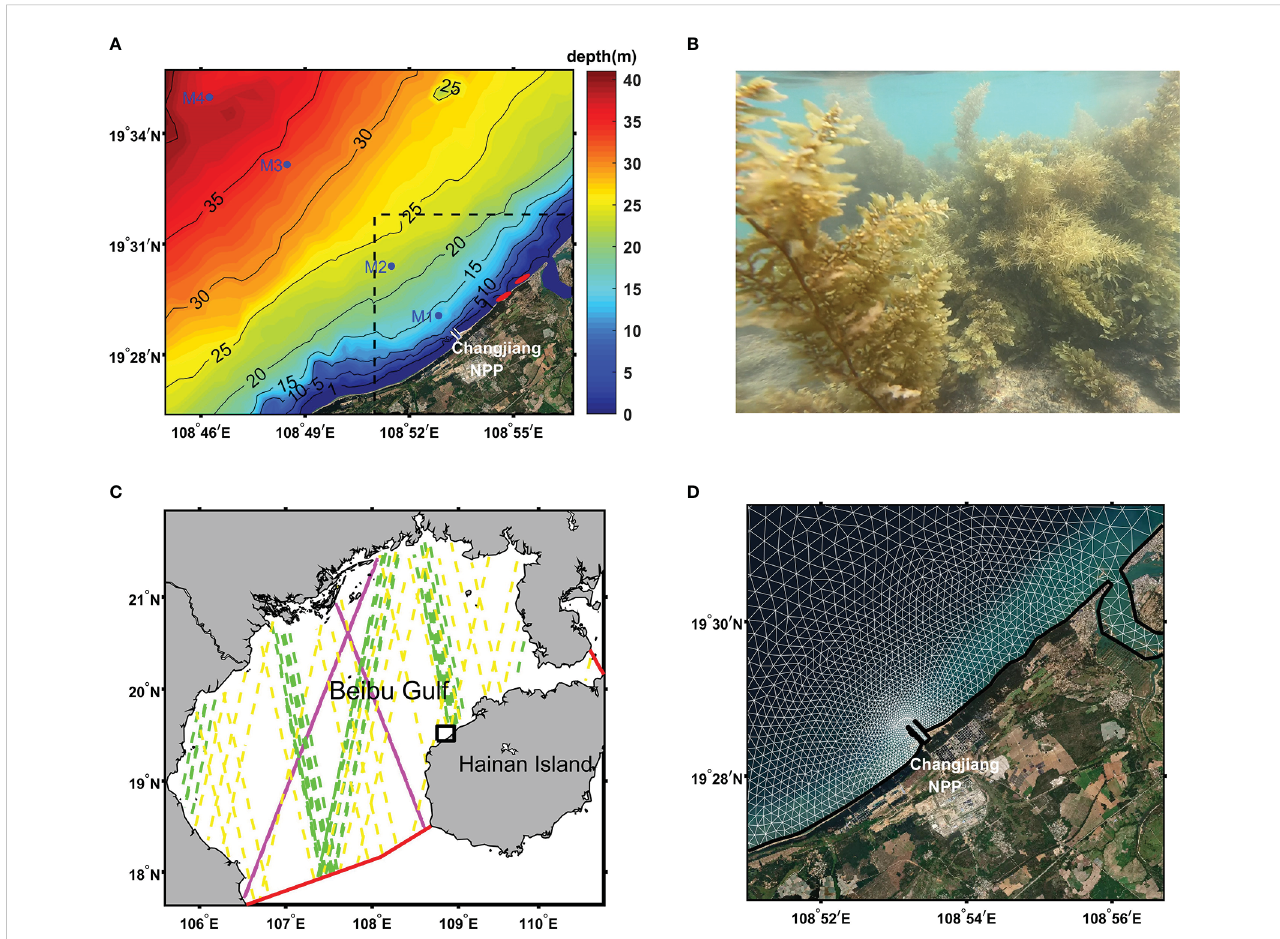
FIGURE 1 (A) The study region with bottom topography (colored shading). The positions of current stations are indicated by blue markers. The two red elliptical markers indicate the locations of two gulfweed source sites near the coast. The dashed rectangular box marks the area of particle release in particle- tracking simulations, whereas the solid white line at the coast outlines the inlet mouth of the Changjiang nuclear power plant (NPP). (B) Photograph of gulfweed taken at the source locations. The gulfweed plants in the photograph are approximately 2 m in height. (C) Model domain. The two solid red lines are the open boundaries of the model. Dashed lines track the Jason-3 (magenta), SARAL/AltiKa (yellow), and CFOSAT (green) satellite trajectories from late December 2018 to early April 2019. The solid black rectangular box corresponds to the study region. (D) Computational grid in the study region (white line). Note that this is only part of the model grid. The entire grid over the model domain is not